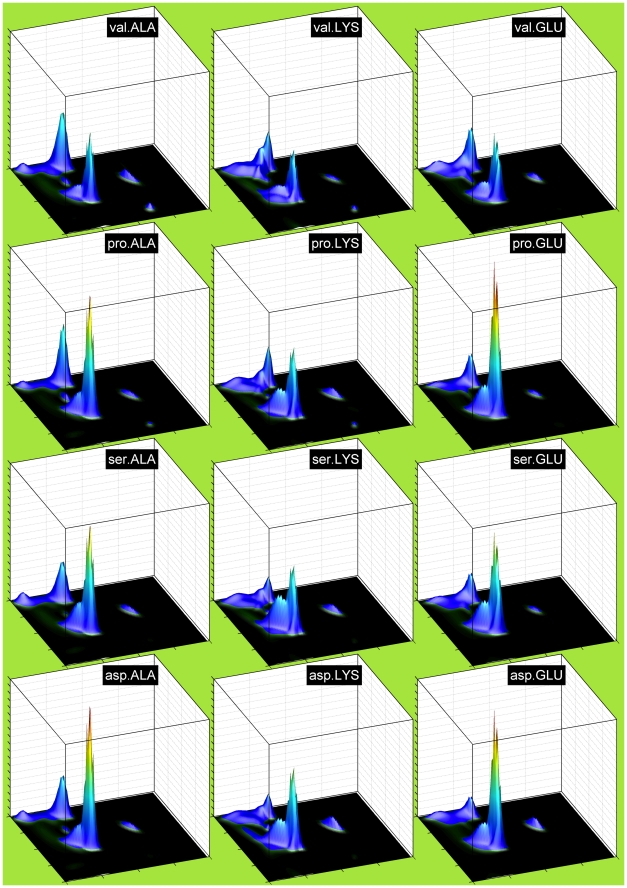
Left neighbor-dependent Ramachandran distributions of three residue types.Columns (left to right): central residues ALA, LYS, and GLU. Rows (top to bottom): left neighbors val, pro, ser, and asp. Vertical scale is the same as Figure 5.